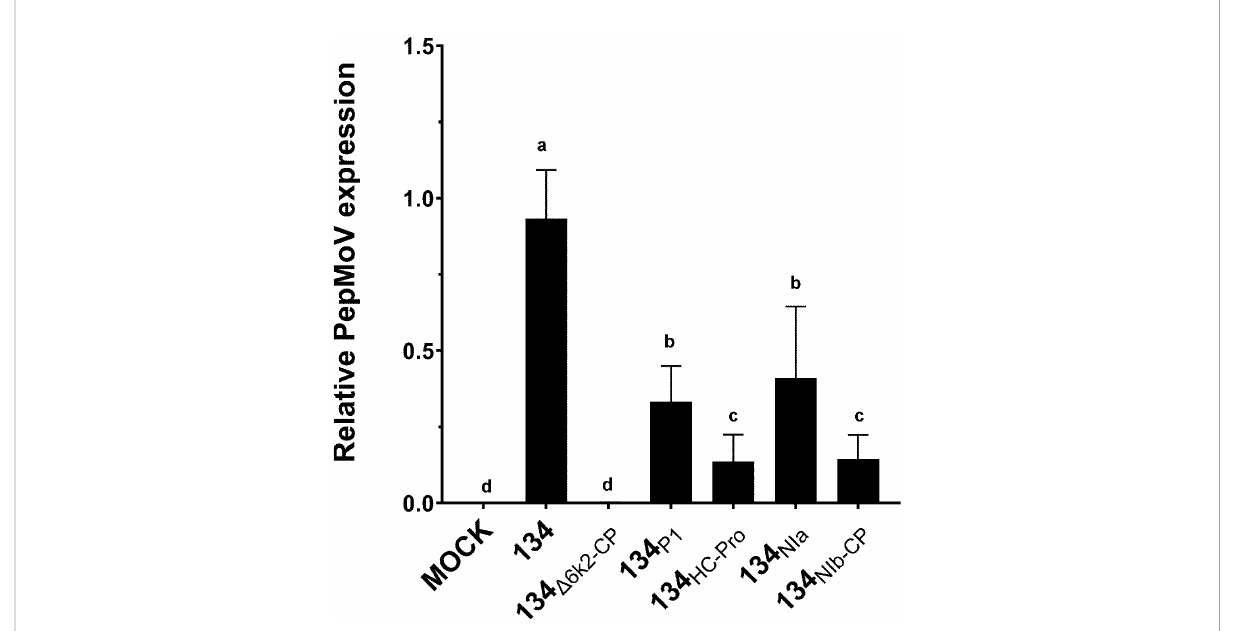
FIGURE 4 Quanti fi cation of protoplast viral accumulation at 1 dpi. Mean values with different letters indicate signi fi cant differences ( P < 0.05) between 134 and chimeric mutants according to a one-way ANOVA and Duncan ’ s least signi fi cant range test ( P <